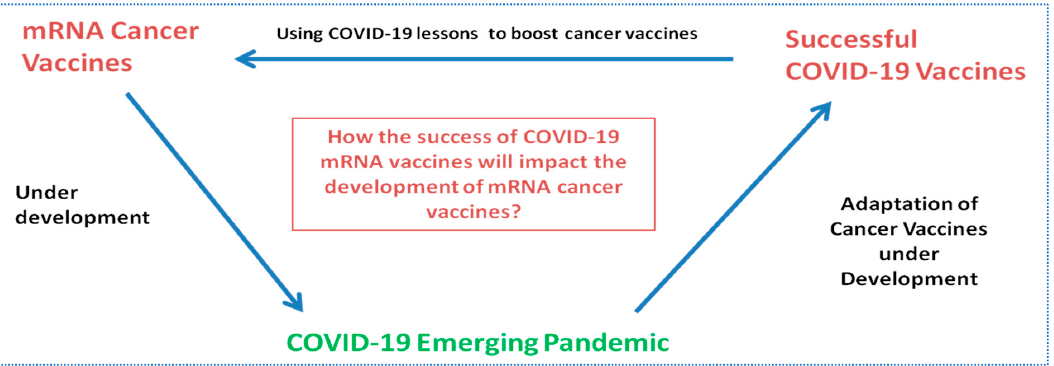
Figure 1. Influence and relationship in the development of mRNA cancer vaccines and mRNA vac-